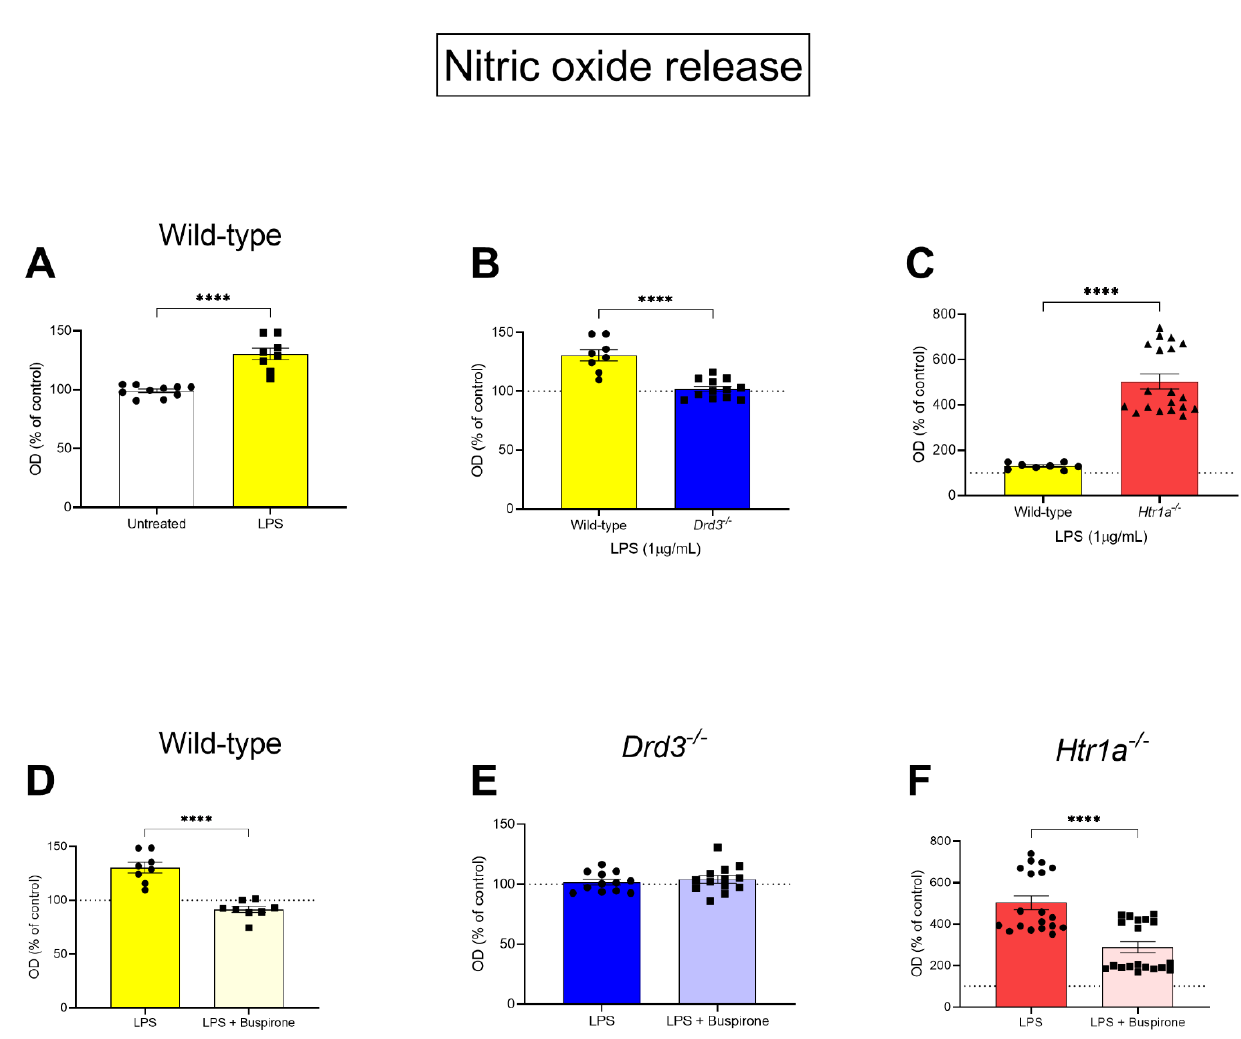
Figure 3. Nitrate levels in BV-2 wild type, Drd3 −/− and Htr1a −/− cells after treatment with LPS in the presence of buspirone or not. Cells were treated for 24 h with either vehicle, 1 µ g/mL LPS or 1 µ g/mL LPS and 300 µ M buspirone. Supernatants were then collected and placed in a new 96-well plate and incubated with Griess reagent for 15 min at room temperature, then read at 540 nm. Data shown are the optical density (OD), expressed as percentage of untreated WT cells (dotted lines). ( A ) Bar graph showing nitrate levels in wild-type BV-2 cells treated or not with LPS alone for 24 h. ( B , C ) Comparative assessment of NO release between ( B ) wild-type and Drd3 −/− or ( C ) wild-type and Htr1a −/− cells after treatment with LPS. ( D – F ) Bar graphs depicting NO levels in the supernatants of ( D ) wild-type, ( E ) Drd3 −/− and ( F ) Htr1a −/− cells after treatment with LPS and buspirone. Values are reported as the percentage NO release of untreated controls (dotted lines, except in A ). Data reported as mean ± SEM. **** p < 0.0001 vs. LPS or untreated control, as determined by unpaired t -test.